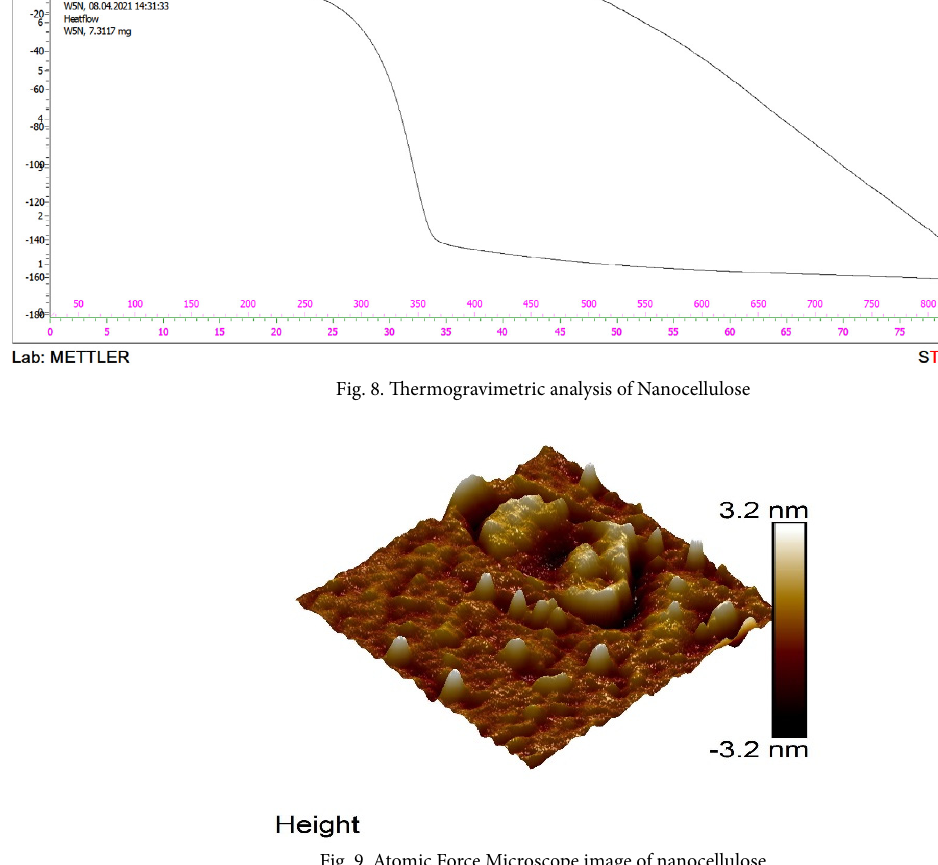
Fig. 9. Atomic Force Microscope image of nanocellulose